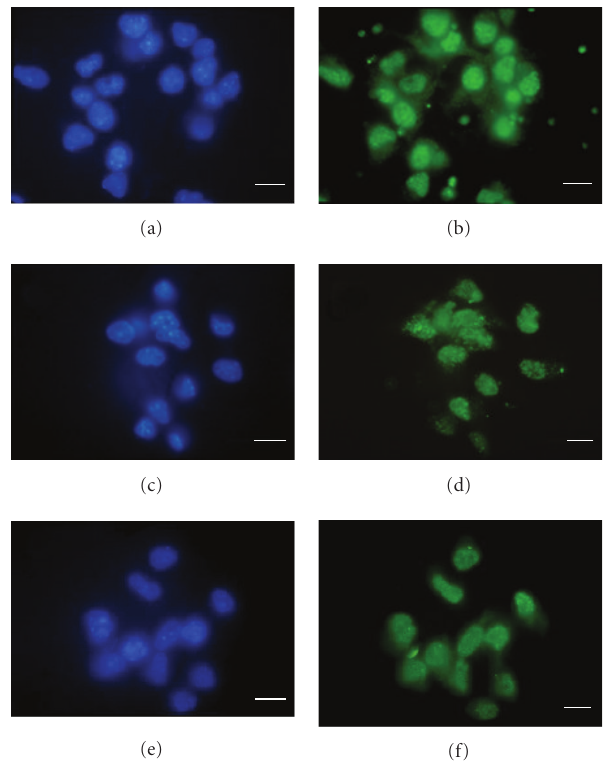
Figure 3: PPARs immunolocalization in S0 neurospheres. (b) PPAR α , (d) PPAR β , (f) PPAR γ . Hoechst nuclear staining is shown in (a), (b), and (c), respectively. Bar = 20 μ